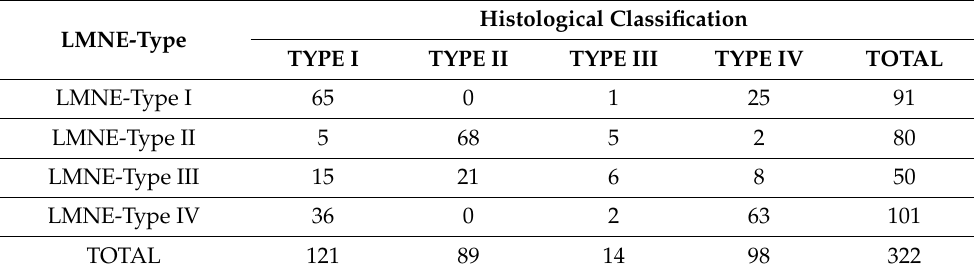
Table 2. Distribution of the patients according to the four different LMNE-matrices and the histologi- cal types described by Morawietz and Krenn